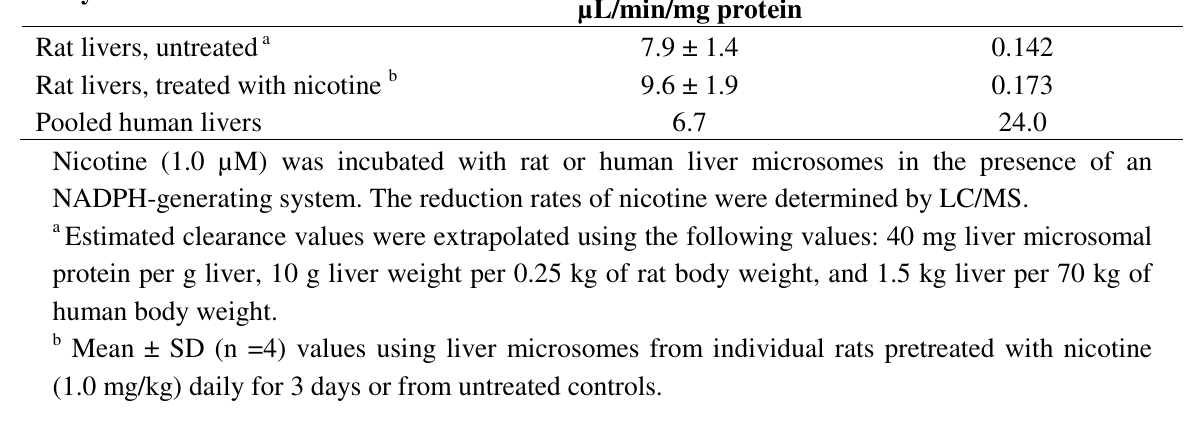
Table 3. In vitro hepatic intrinsic clearance of nicotine determined using liver microsomes. Enzyme